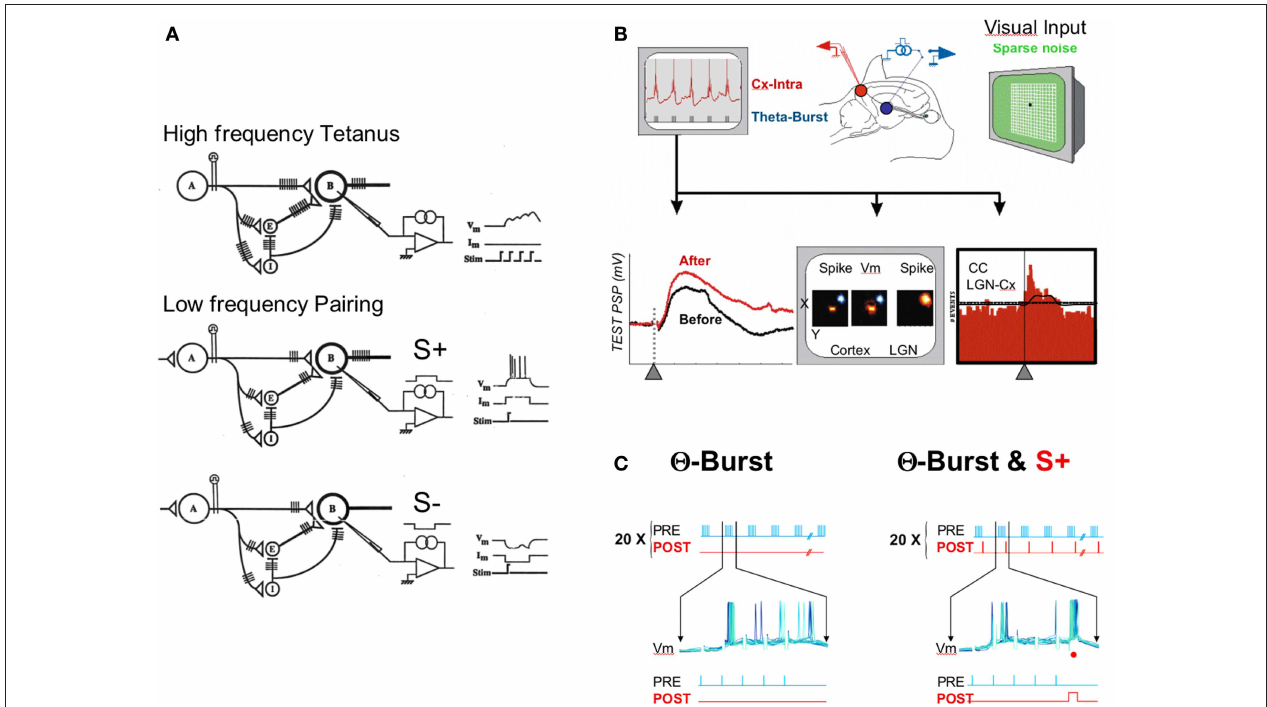
pulses repeated at a theta-rhythm is applied in the thalamus (in blue) while recording intracellularly from a potential target cortical cell (in red). The synaptic response to a low frequency (0.2 Hz) thalamic stimulation (lower left inset), the visual receptive field maps (middle) and the cross-correlation histograms between thalamic and cortical spikes (CC, right lower inset) are compared before and after conditioning. In (C) , the intracellular membrane potential (Vm) recording during TBS (left panel) is visualized during the burst period. In the TBS_ S + protocol example (right panel), each fifth stimulation pulse in the high frequency burst of the TBS is paired with a depolarizing intracellular pulse (red dot) forcing the cortical cell to